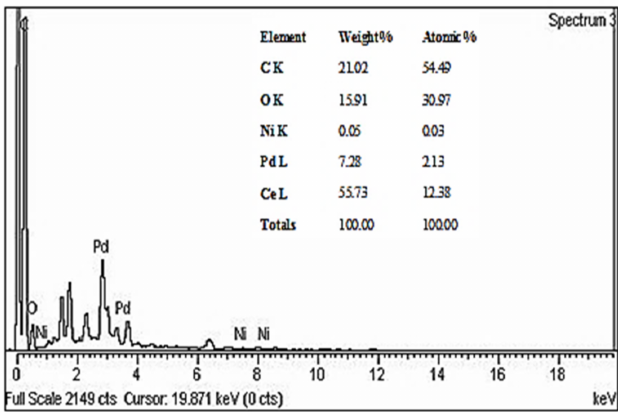
Figure 5. EDX analysis of Pd-NI/AC-CeO 2 .